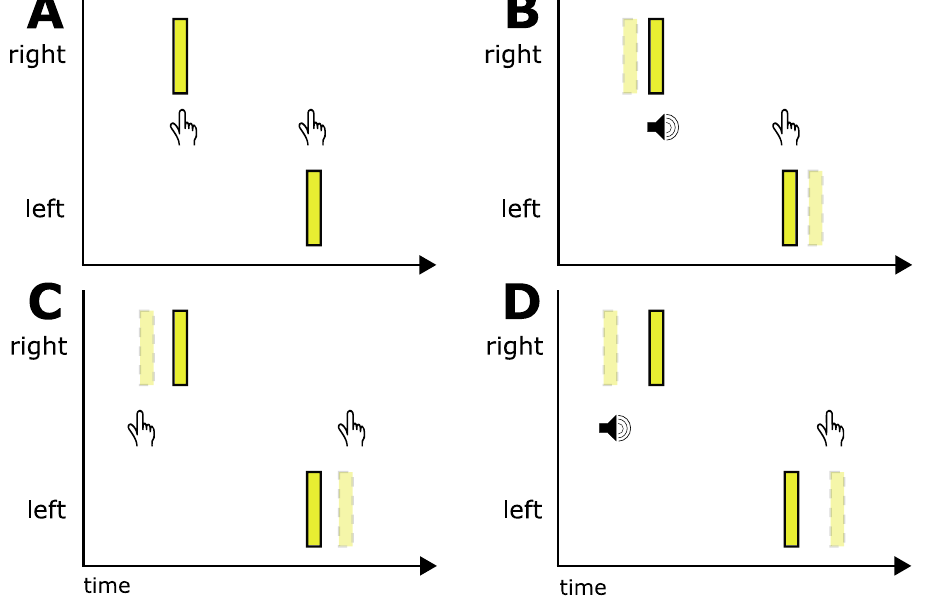
Figure 2. Experimental manipulations of timing and cross-modal flanker similarity in a temporal ventriloquism paradigm based on Morein-Zamir et al . 9 . ( A ) Identical flankers presented synchronously with the onset of visual events. ( B ) When cross-modal flankers are presented synchronously but differ in modality (or feature within modality), TOJ performance is consistent with the perceived timing of the visual onsets being further apart. ( C ) When the flankers are identical and presented asynchronously to the visual onsets, TOJ performance is similarly improved (temporal ventriloquism). ( D ) When flankers differ and are presented asynchronously, TOJ performance is improved consistent with the timing of the visual onsets being even further